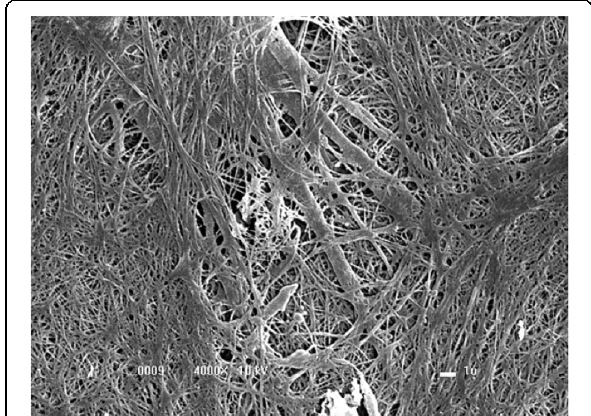
Fig. 2 Stable fibrin network visualized in an electron microscope (4,000×). Reprinted from “ A new fibrin sealant as a three-dimensional scaffold candidate for mesenchymal stem cells ” by VPO Gasparotto et al., Stem Cell Res Ther, 2014, 5(3), 78 [10]. Copyright by VPO Gasparotto et